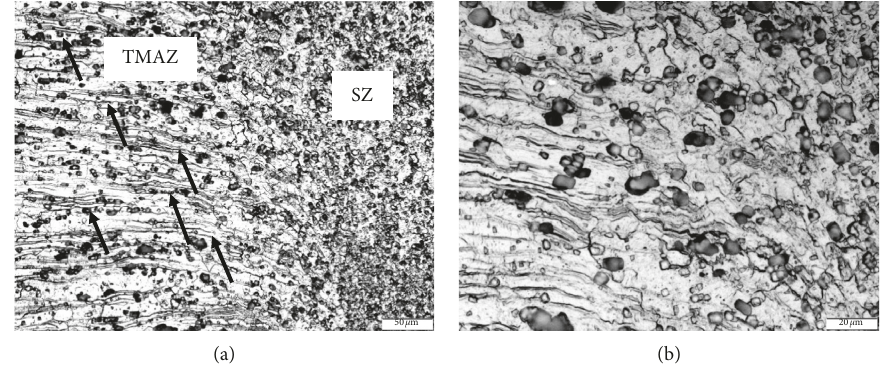
Figure 5: Optical micrographs of TMAZ of the sample welded at 70mm/min, at different magnifications.